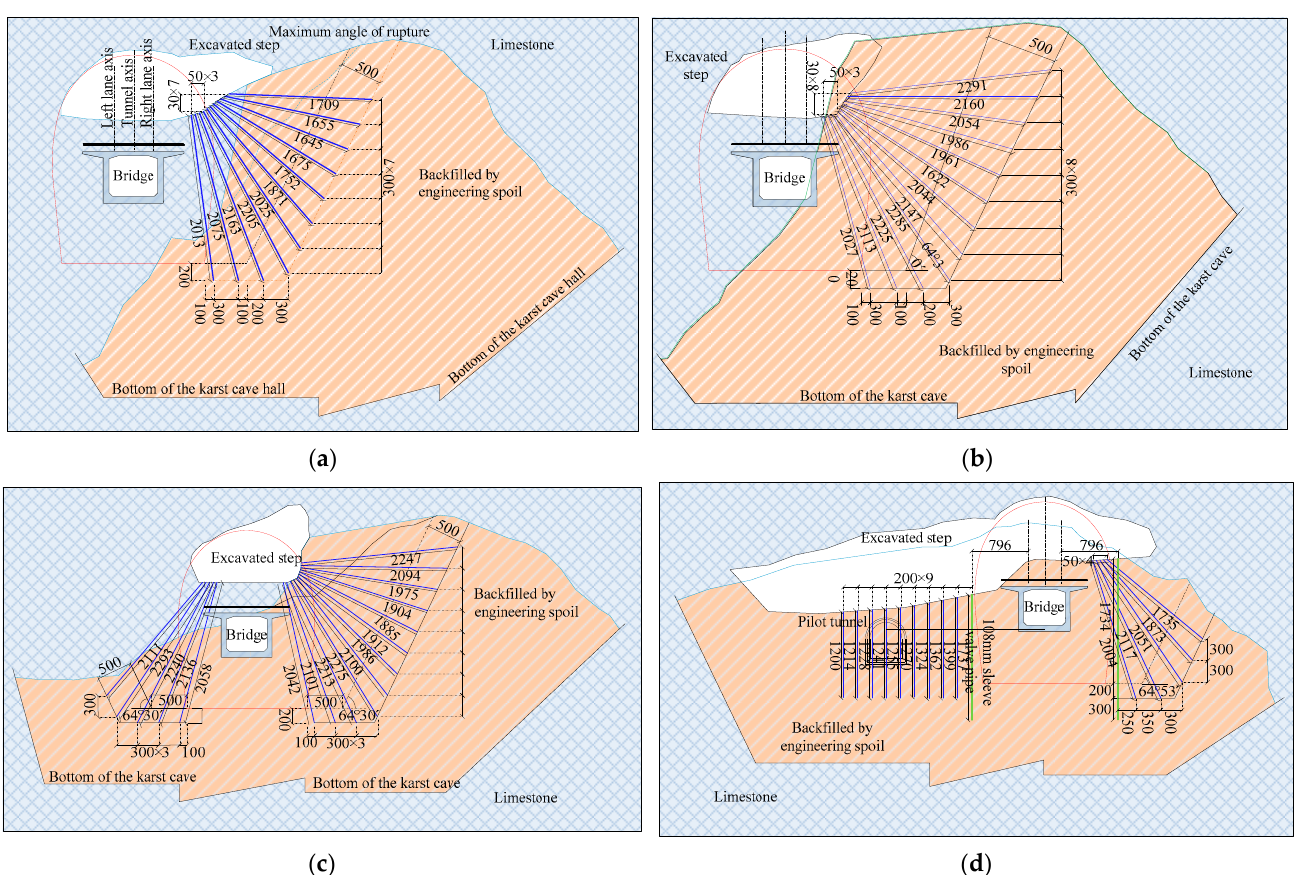
Figure 12. Grouting hole drilling design in typical section of ( a ) D3K279 + 883 ( b ) D3K279 + 888 ( c ) D3K279 + 903 and ( d ) D3K279 + 938.